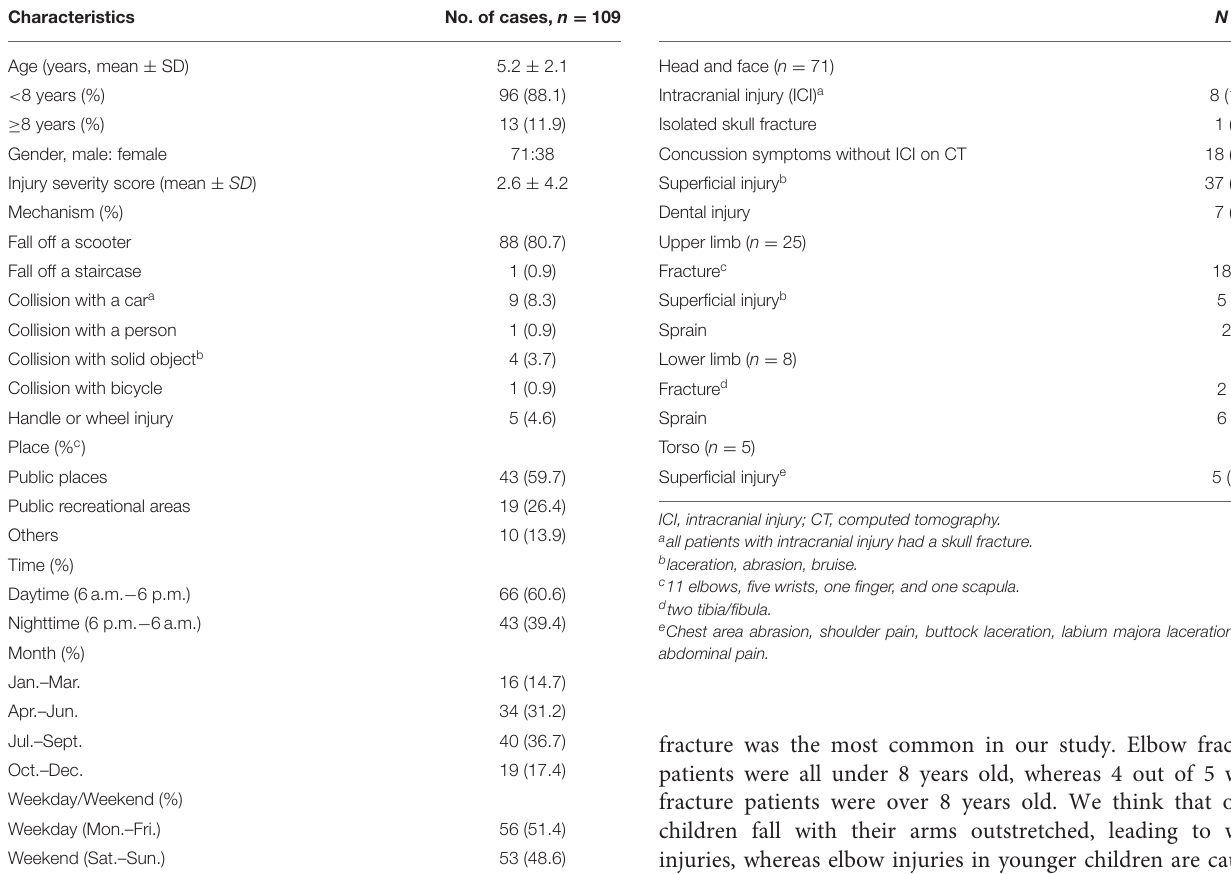
TABLE 2 | Types and sites of